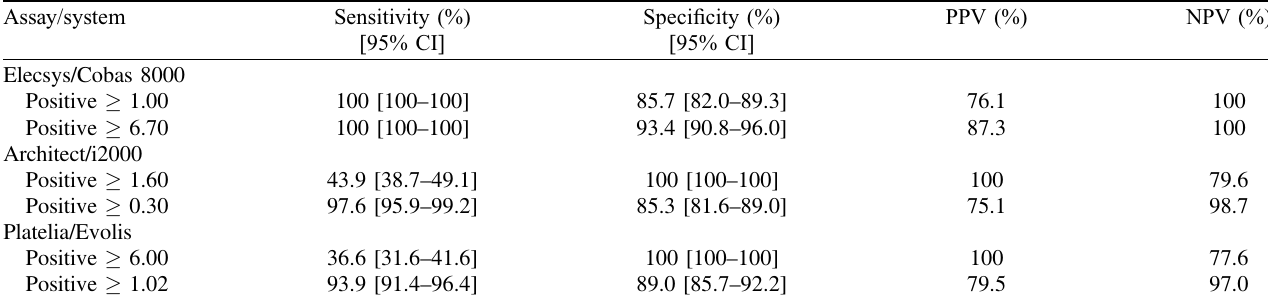
Table 5. Sensitivity, speci fi city, PPV, NPV of each reagent (former and new thresholds), 31.3% prevalence.